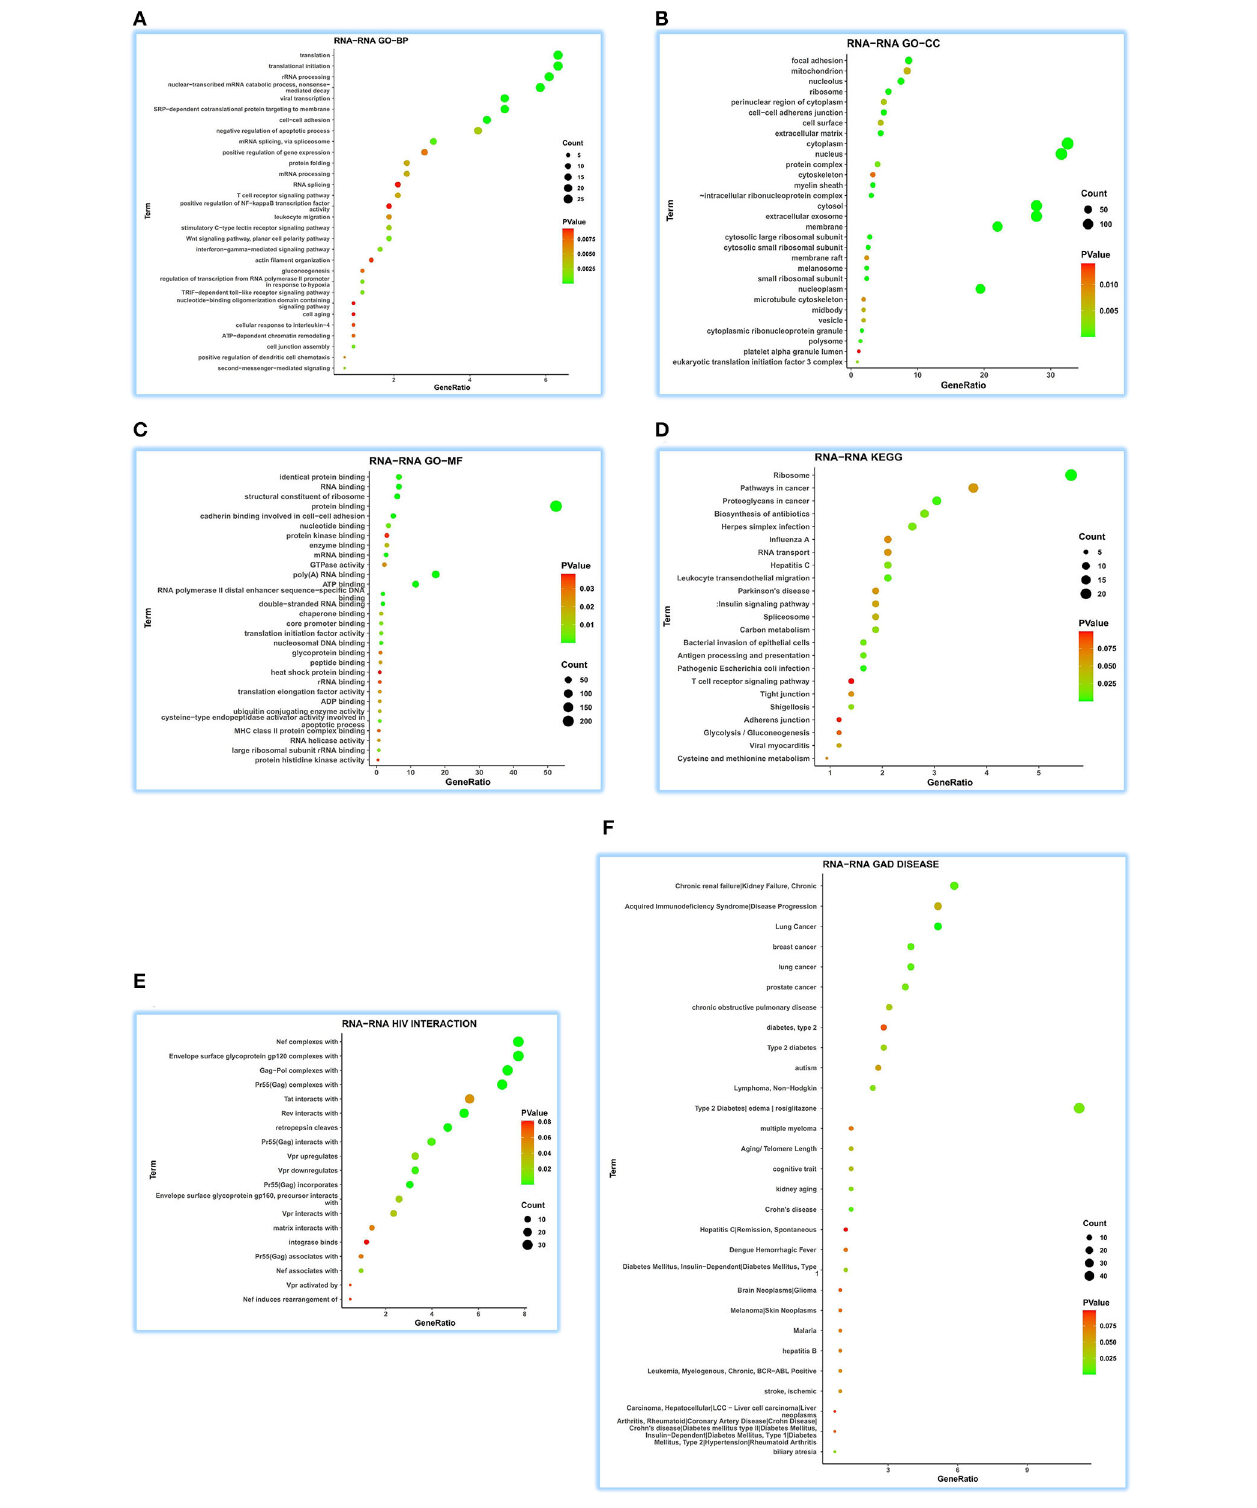
FIGURE 5 | Extensive function annotations of ATP5MG by RNA-RNA interaction analysis. DAVID tool was enlisted to analyze GO, KEGG, HIV interaction, and GAD DISEASE based on 507 genes that can regulate ATP5MG by RNA-RNA interaction in 32 human tissues. The top 30 terms for each group were visualized. ATP5MG may function diversely. (A) Function annotations for GO-BP. (B) Function annotations for GO-CC. (C) Function annotations for GO-MF. (D) Function annotations for KEGG pathway. (E) Function annotations for HIV interaction. (F) Function annotations for GAD DISEASE. GO, Gene Ontology; BP, biological process; CC, cellular component; MF, molecular function. KEGG, Kyoto Encyclopedia of Genes and